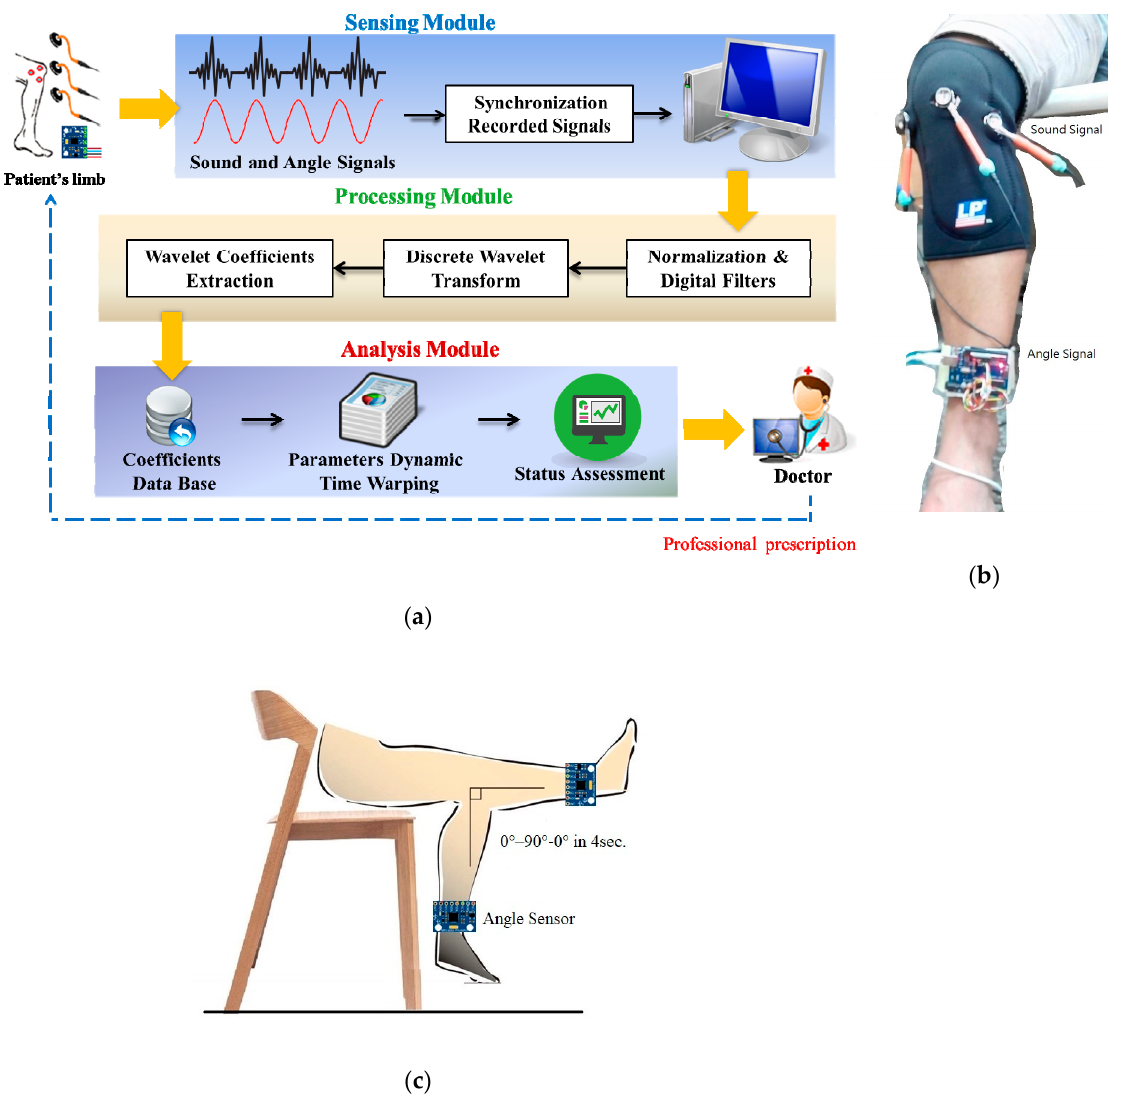
Figure 1. System architecture and measuring method: ( a ) data processing procedure in the three modules, ( b ) photograph showing the three sound sensor positions and angle sensor, and ( c ) 4-s swing cycle from flexion to extension to flexion (0° to 90° to 0°, respectively).